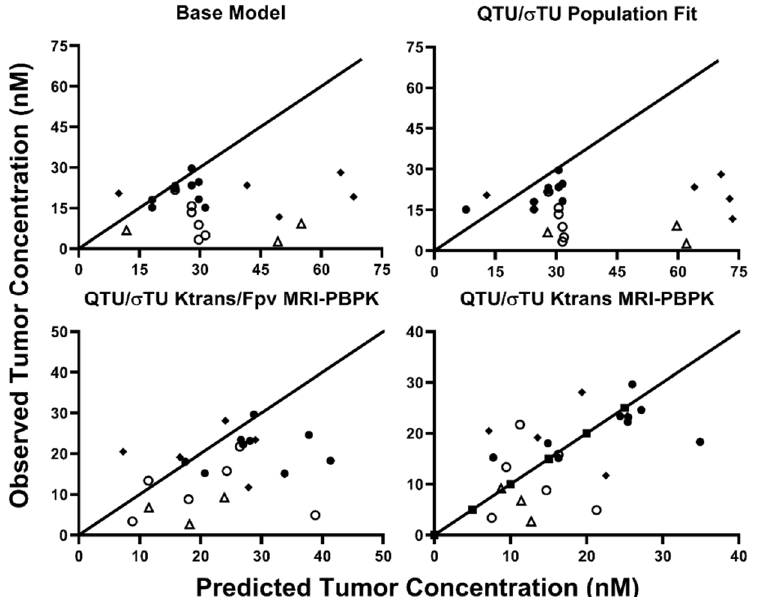
Figure 6. Observed vs. Predicted Cetuximab Tumor Concentrations: Predicted vs. observed plots demonstrating the unity of predictions with the base model, population fit model, and the two-best covariate-integrated models. Tumor data in LS174T tumors following treatment with Sorafenib are represented in open circles, naïve LS174T tumors are depicted in closed circles. Panc-1 tumors are represented by an upright open triangle, and NCI-N87 data are represented by closed diamonds.